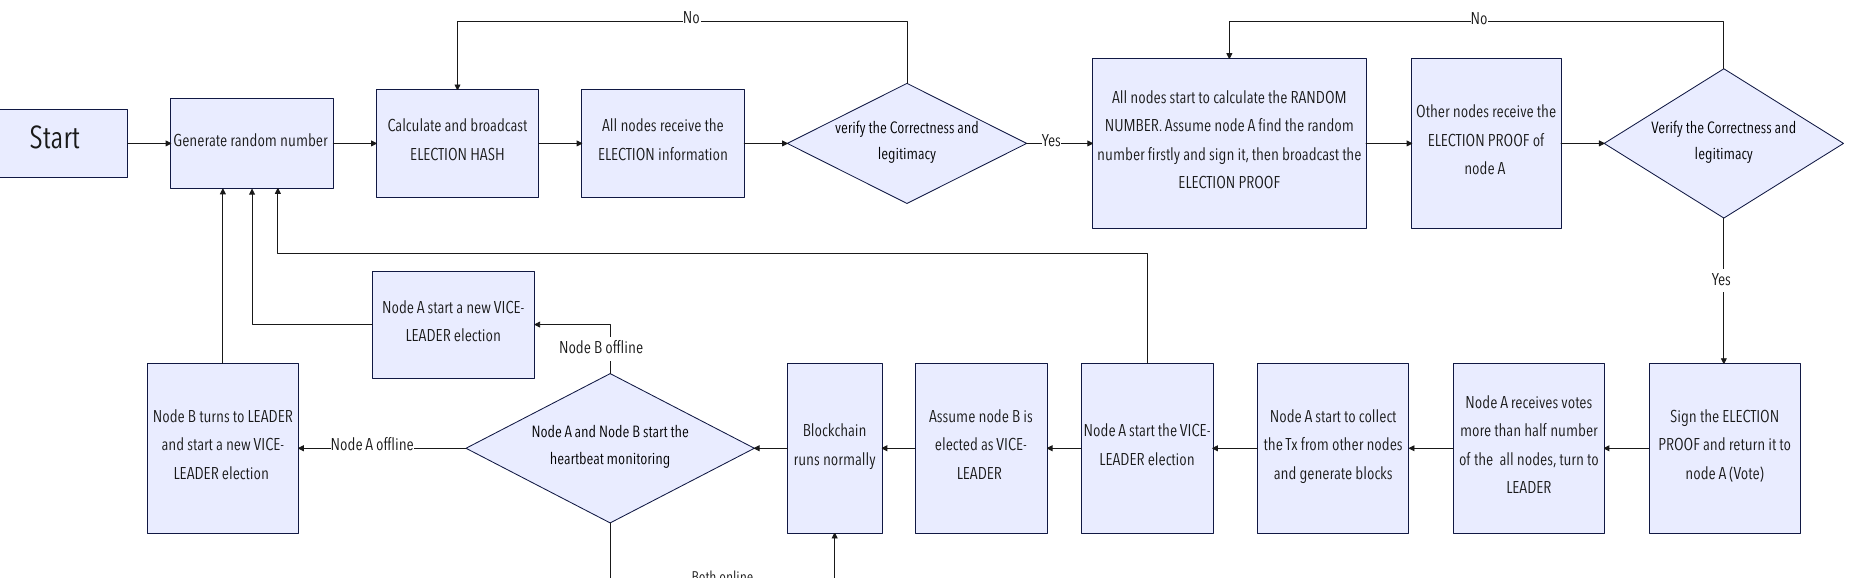
Figure 1. An illustration of PoC consensus